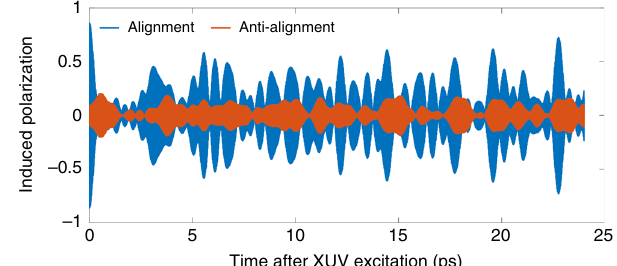
Fig. 4 Calculated induced dipole moment for a rigid rotor linear molecule based on N 2 . A rotational wavepacket is created in the ground state by the pump pulse, and the XUV pulse arrives at a later time t x . If t x is during a rotational revival (blue), then a greater polarization is induced. On the other hand, if t x is when the molecules are perpendicular to the polarization, then fewer molecules are excited. A larger induced polarization signal causes a greater absorption in the frequency spectrum. The rotational constants